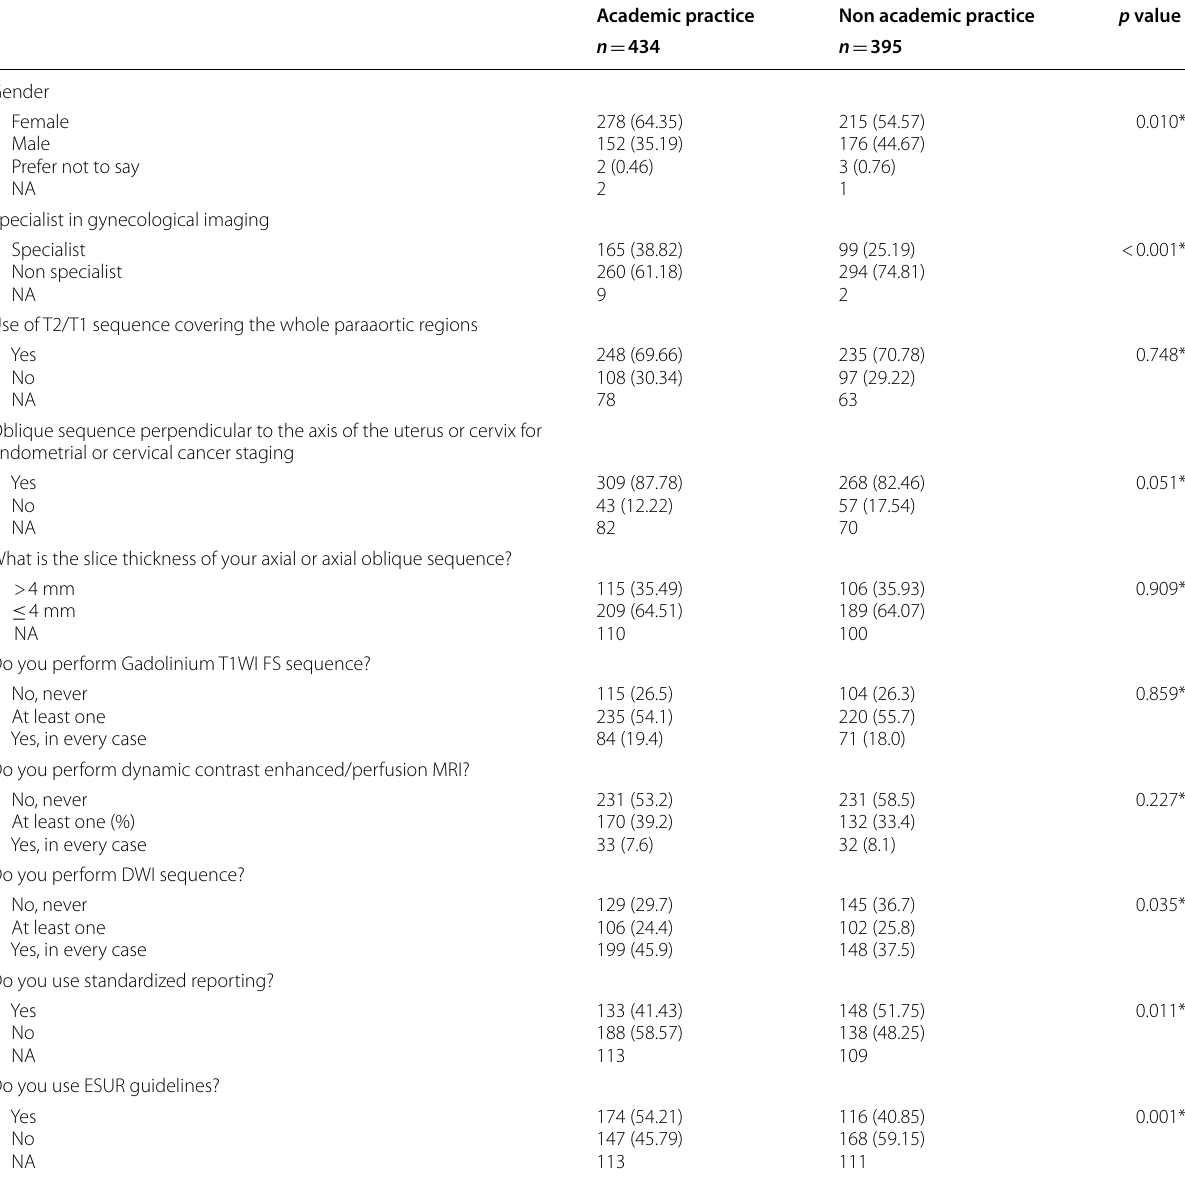
Table 3 Subgroup analysis regarding type of